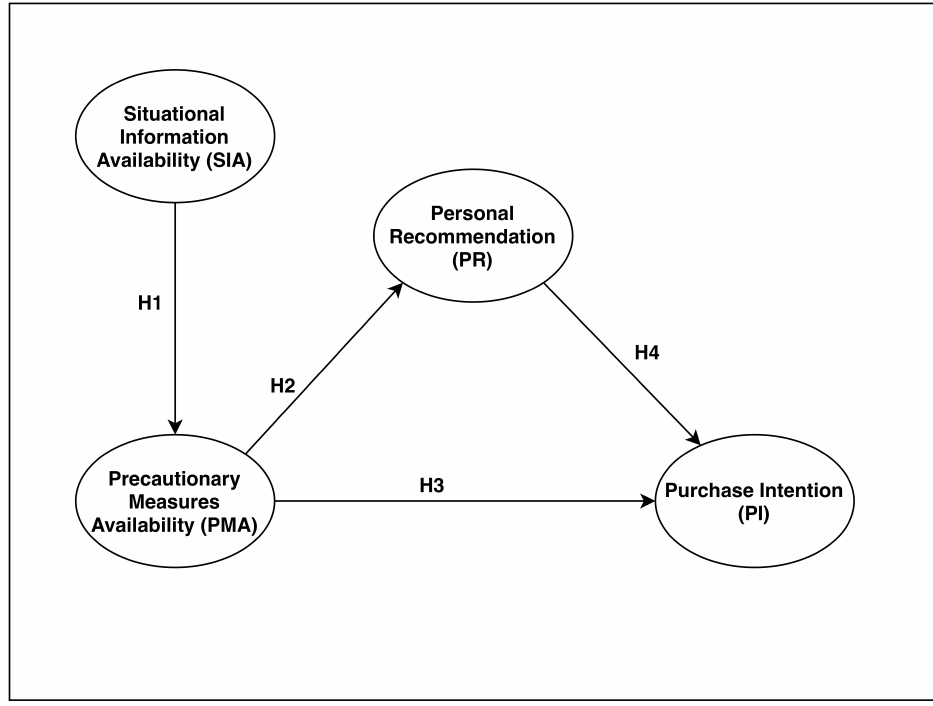
Figure 2. Research